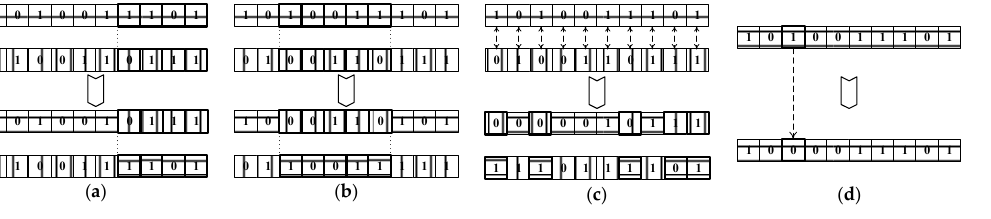
Figure 1. Typical crossover and mutation operators in the GA. Changed alleles are indicated using bold squares. ( a ) One-point crossover; ( b ) two-point crossover; ( c ) uniform crossover; ( d ) mutation. After crossover and mutation, the fitness values of new chromosomes are evaluated